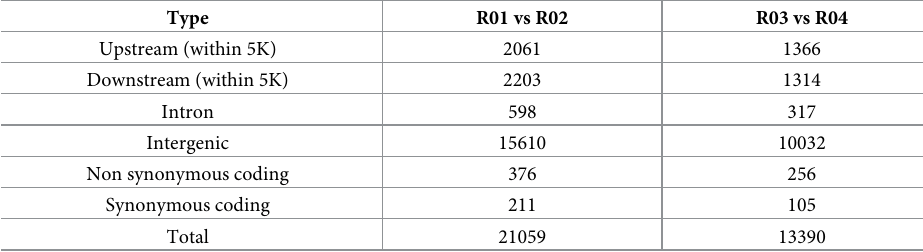
Table 2. Statistics of SNP annotation results in candidate regions.